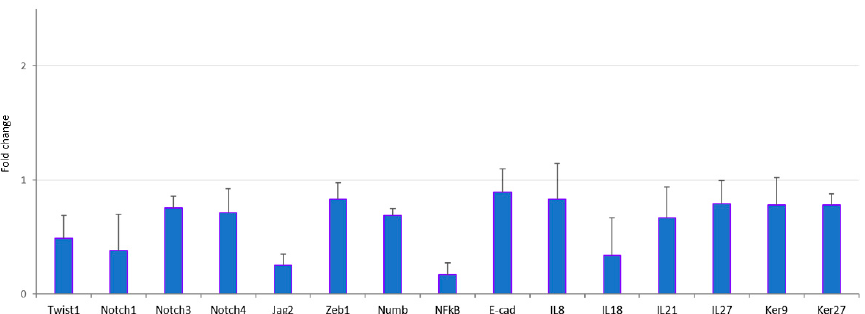
Figure 3. Validation of the Clariom TM S array analyzed transcripts using qRT-PCR. The hTCEpi cells were cultured in the presence of AC EFs and RNA was isolated after 24 h. Reverse transcription was performed using 1 µ g of total RNA to prepare cDNA and qRT-PCR was performed to compare the expression analysis of different transcripts using respective primers for Twist1, Notch1, Notch3, Notch4, Jag2, Zeb1, Numb, NFkB, E-Cad, IL8, IL18, IL21, IL27, Ker9 and Ker27. Relative expression patterns were analyzed using the comparative threshold cycle (2 − ∆∆ C t ) method. Expression values are represented as fold changes over the control on an arbitrary scale after normalization with GAPDH. Further, these transcripts displayed similar expression profile during Clariom TM S Arrays. Data represent means ± standard deviations of Genes 2021 , 12 , x FOR PEER REVIEW three independent experiments.